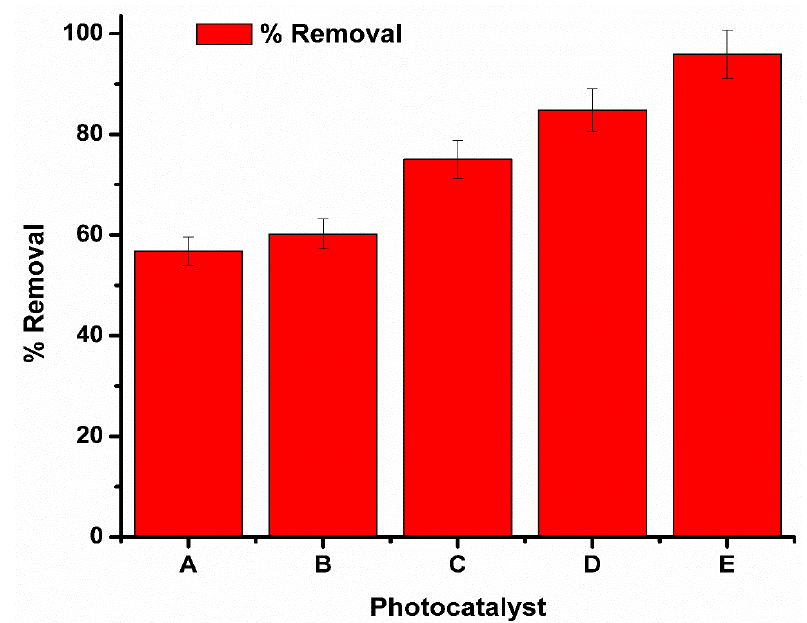
Figure 10. Percentage removal for chlorpyrifos (1000 ppb) using 0.1 g of ( A ) WO 3 , ( B ) Mn-WO 3 , ( C ) SnS 2 , ( D ) WO 3 / SnS 2 and ( E ) Mn-WO 3 / SnS 2 .